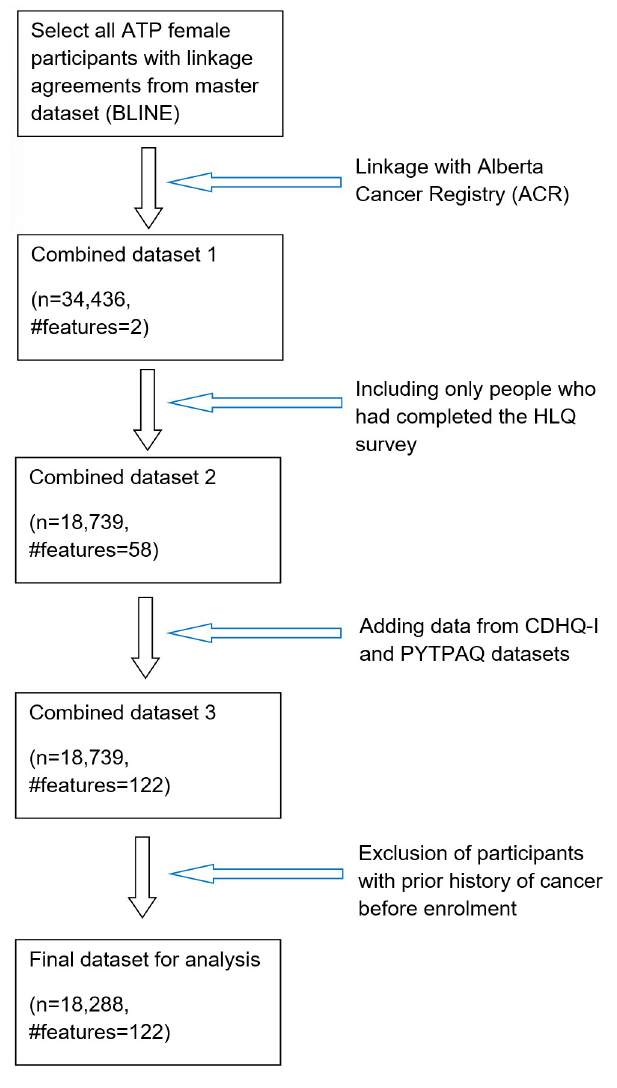
Fig 2. Scheme of data